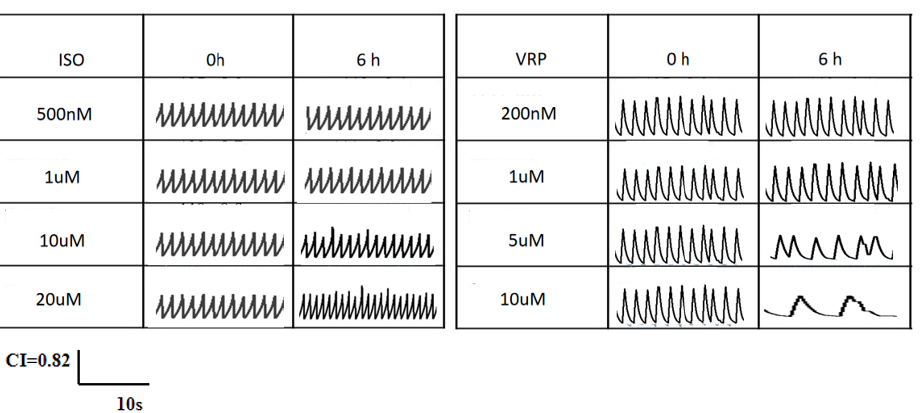
Figure 7. Beat signal changes in the cardiomyocyte QCM sensors after treatment with different con- centrations of isoproterenol (ISO) and verapamil (VRP), with a time lapse of 10 s for the signal frag- ments and a maximum Δ f of 1050 Hz.